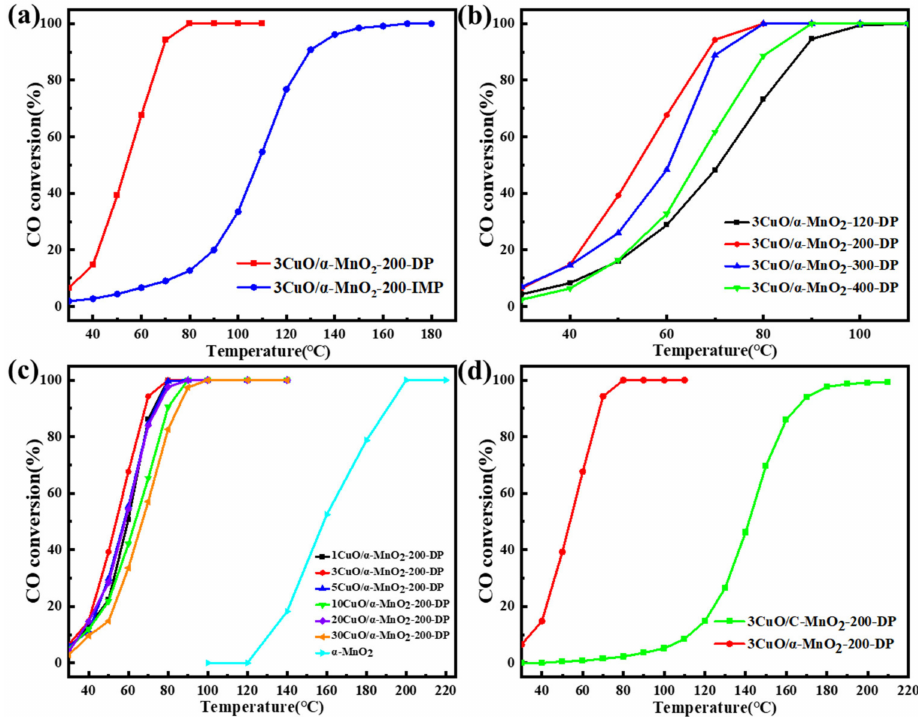
Figure 9. ( a ) 3CuO/ α -MnO 2 -200-DP and 3CuO/ α -MnO 2 -200-IMP catalysts under different loading modes; ( b ) 3CuO/ α -MnO 2 - T -DP ( T = 120, 200, 300, 400) catalysts; ( c ) x CuO/ α -MnO 2 -200 ( x = 0, 1, 3, 5, 10, 20, 30) catalyst; and ( d ) CO conversion of pure α -MnO 2 nanowires and commercial MnO 2 catalysts supported by CuO by precipitation deposition at different reaction